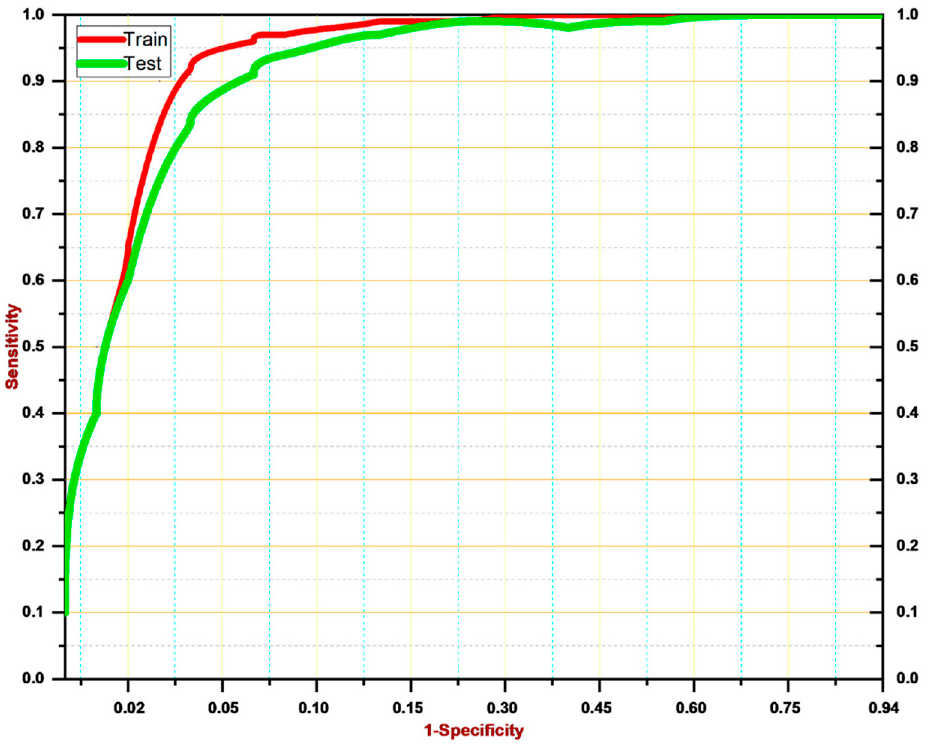
Figure 6. ROC curve for the proposed skin cancer detector .